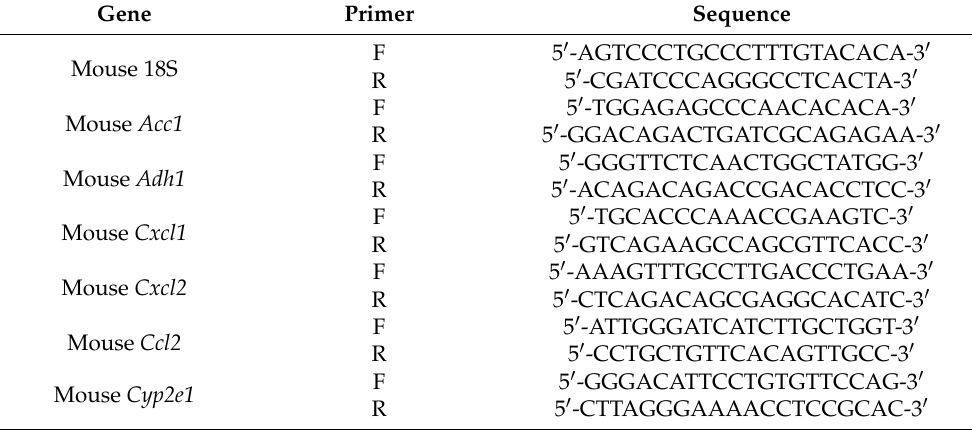
Table 2. Primers used in this